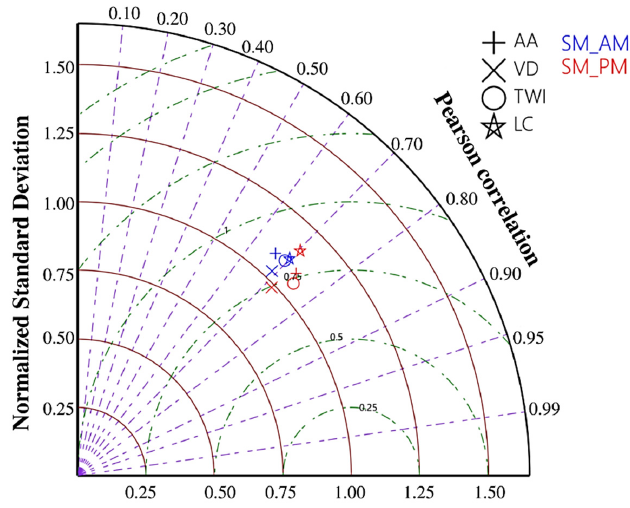
Figure 6. Taylor diagram comparing SMAP L2SMP_E AM/PM observations with soil moisture series derived from the upscaling techniques based on the Arithmetic Average (AA), Voronoi Diagram (VD), Topographic Wetness Index (T), and Land Cover (LC).